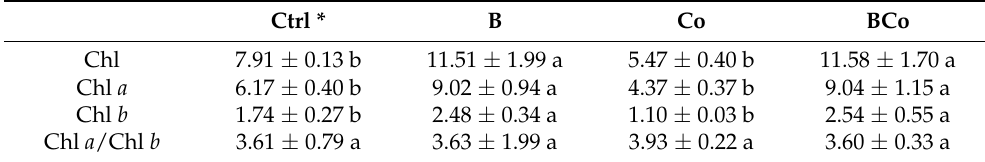
Table 2. Chlorophyll content (mg · cm − 2 ) of P. euramericana grown on four different substrates (Ctrl, B, Co, and BCo). Different letters indicate significant difference ( p < 0.05) ( n = 10 ±